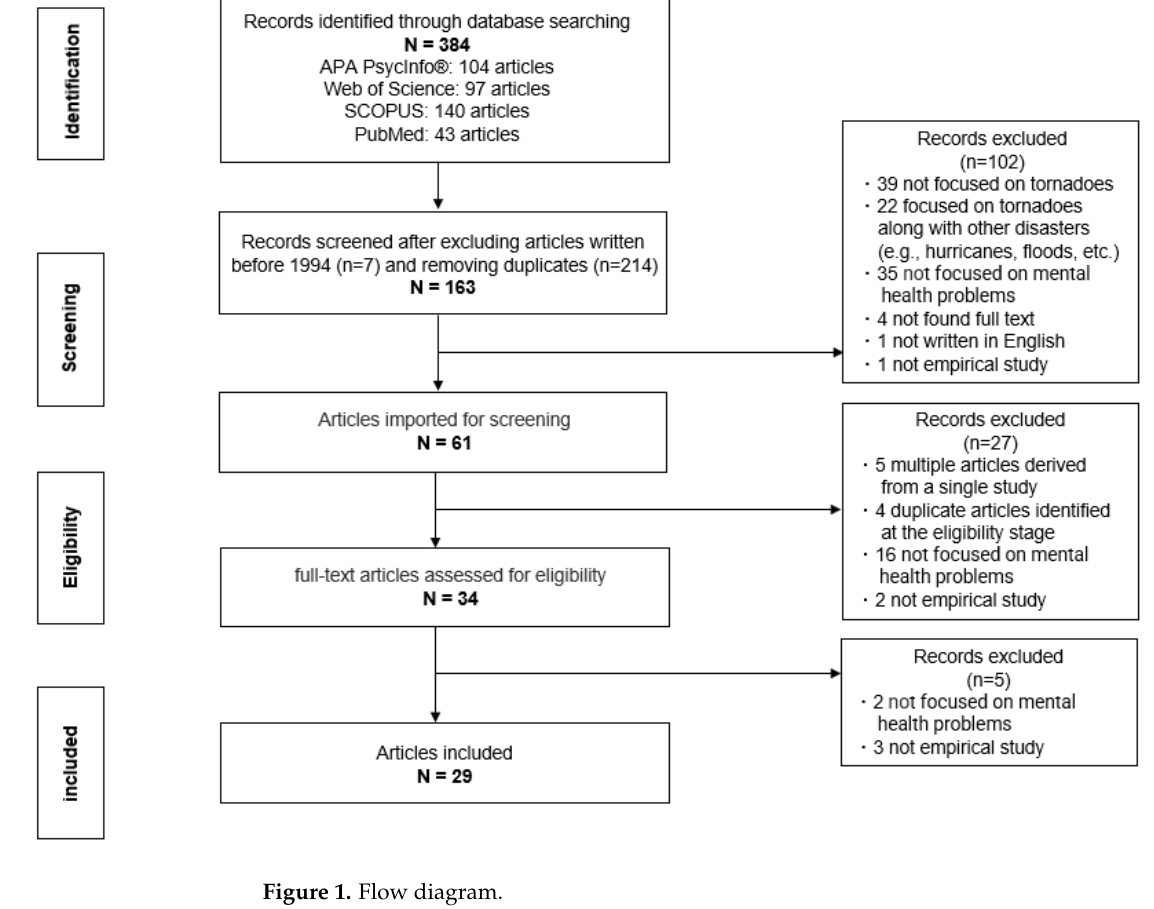
Figure 1. Flow diagram.